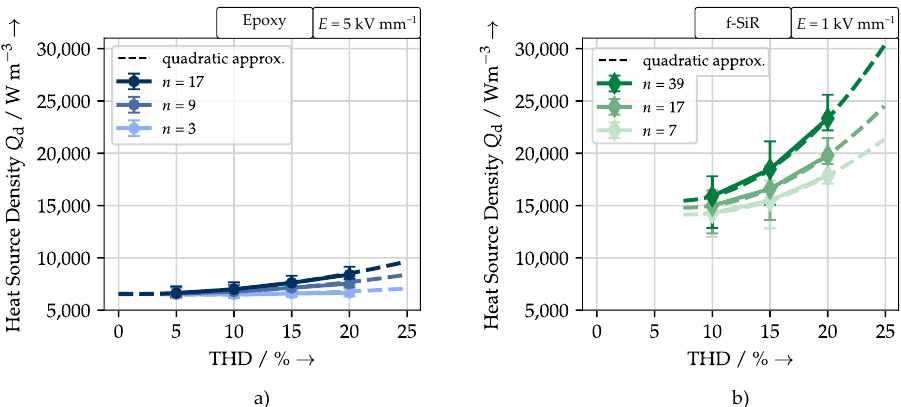
Figure 11. Heat source density as a function of the total harmonic distortion for different orders of harmonic n . ( a ) Epoxy polymer samples, quadratic approximations for THD = (5 . . . 15)% and ( b ) f-SiR samples, quadratic approximations for THD = (10 . . . 20)%, the mean and range of three test